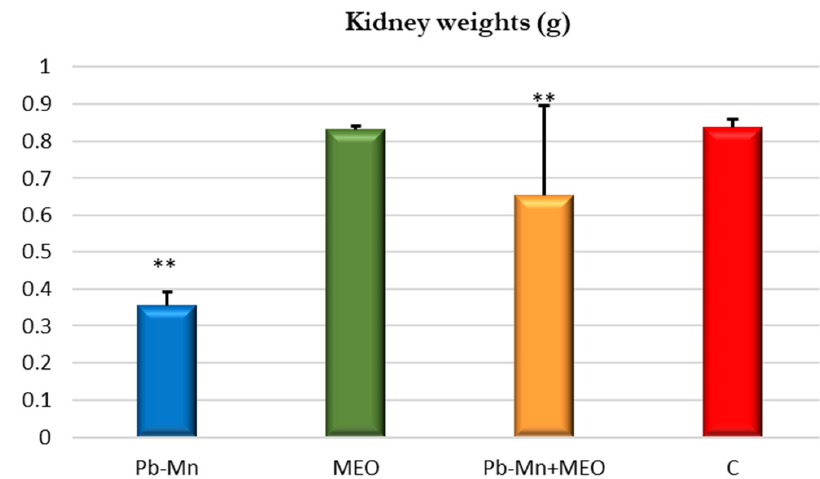
Figure 2. Effect of M. spicata essential oil on the kidney weight in rats intoxicated (Pb-Mn) Data are mean ±S.E.M. ** P<0.01, (Pb-Mn vs.